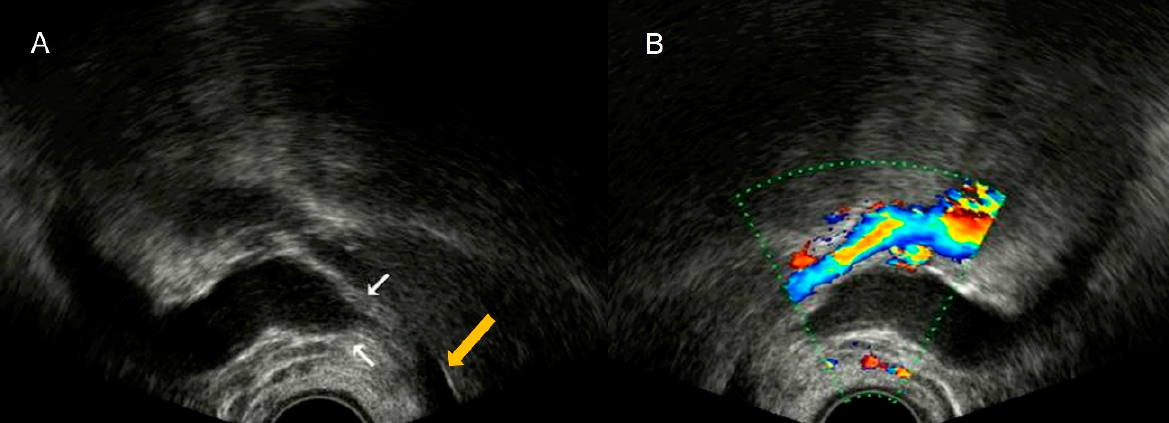
Figure 12. Ultrasound imaging demonstrates a megaureter with tapered distal segment (white arrows) ending at the bladder (yellow arrow) ( A ). Color Doppler shows no vascularization of megaureter ( B ).